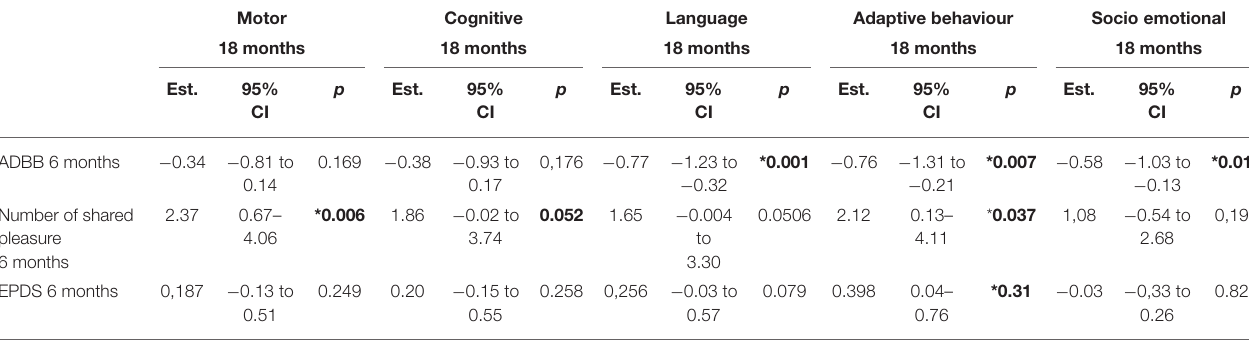
TABLE 6 | SP, EPDS, ADBB 6 months, and BSID-III Composite Scores 18